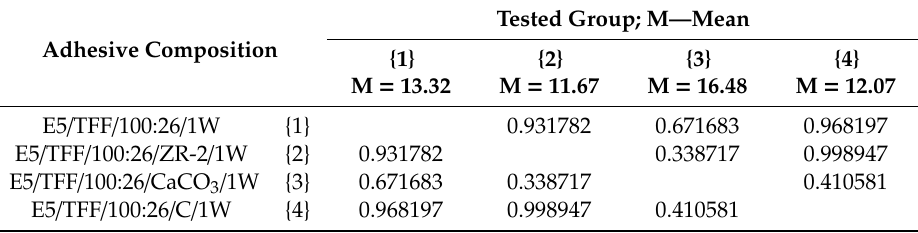
Table 6. Tukey’s honest significant di ff erence test results for the adhesive compositions from the E5 / TFF / 1 week